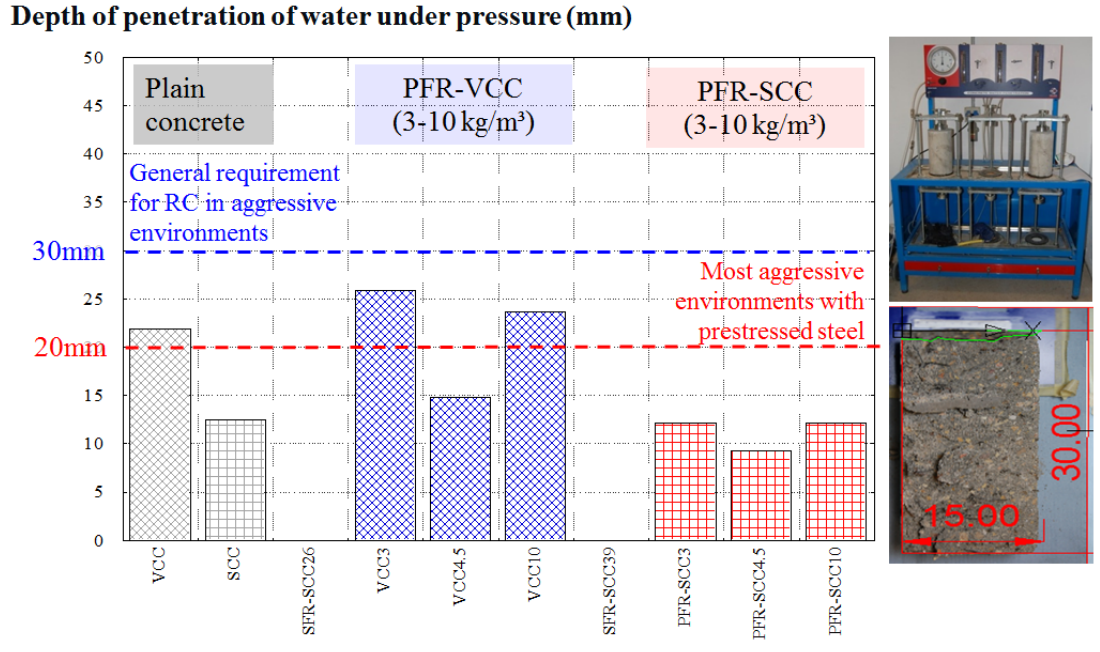
Figure 8. Depth of penetration under water pressure